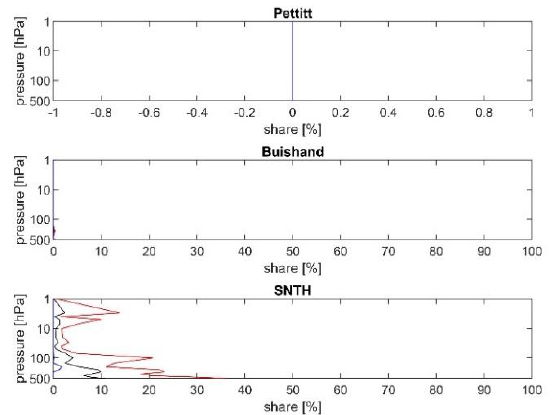
Figure 4. Vertical profile of average (black), minimal (blue) and maximal (red) share of explained discontinuities by the year 2004 to all grids from all months from the Pettitt test for MERRA-2 ( upper panel ), ERA-5 ( middle panel ) and JRA-55 ( lower panel ).